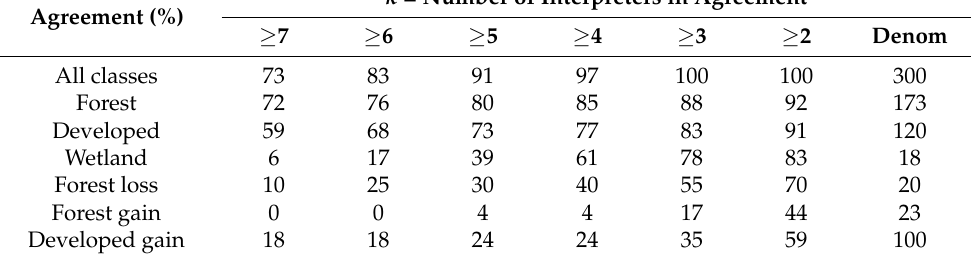
Table 2. Interpreter agreement expressed as a cumulative percent of cases for which k or more interpreters agreed on the class label (e.g., for the forest class and k ≥ 5, of the 173 (Denom) sample pixels labeled as forest by at least one interpreter, 80% had five or more interpreters agreeing on the forest